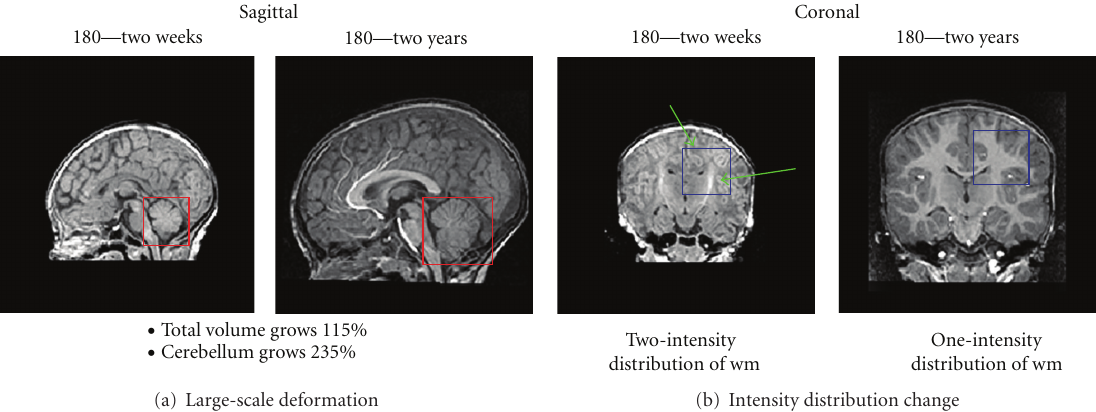
Figure 1: Registration challenges of human brains at early development stages. The image show significant shape and size changes of an infant brain of subject 180 from two weeks to two years as well as the changing white matter properties and appearance due to the